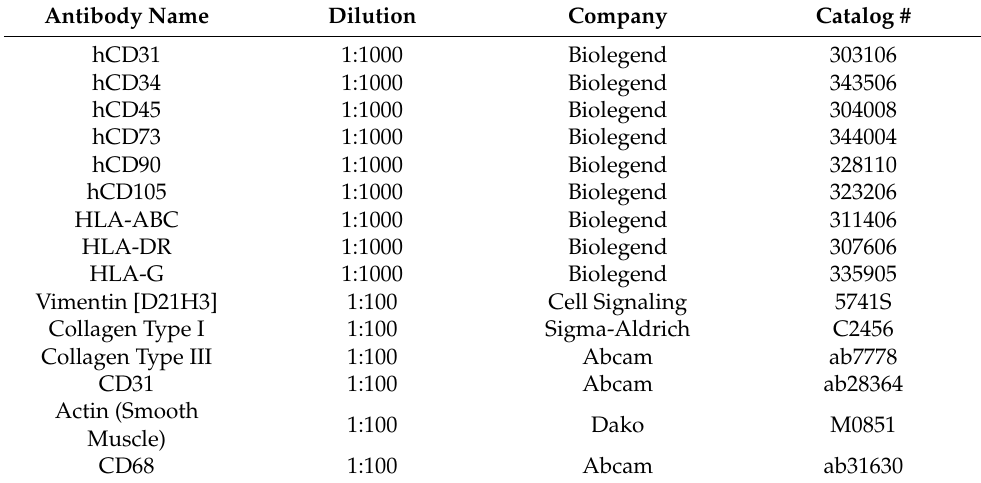
Table 1. The list of antibodies used in this